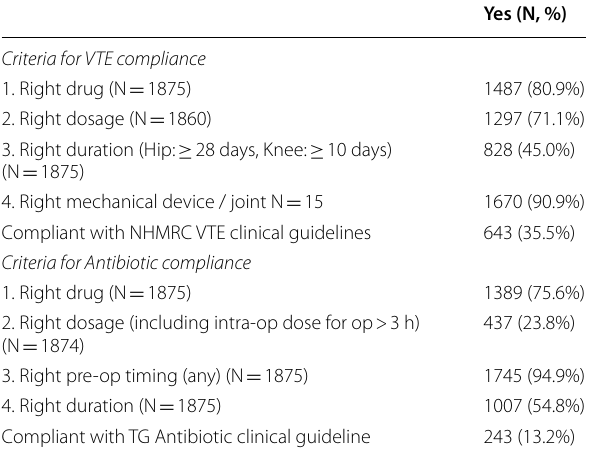
Table 4 VTE and antibiotic clinical guideline compliance